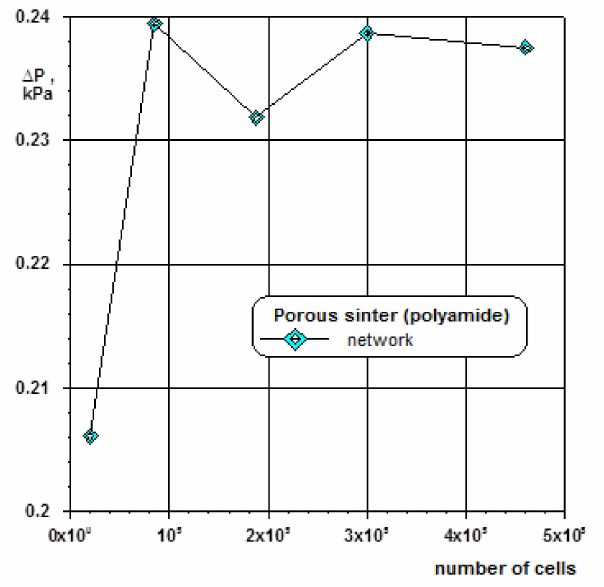
Figure 9. Discretization of model of geometry for cube-shaped network; a = 20 mm, d k = 10 µ m, Ψ =